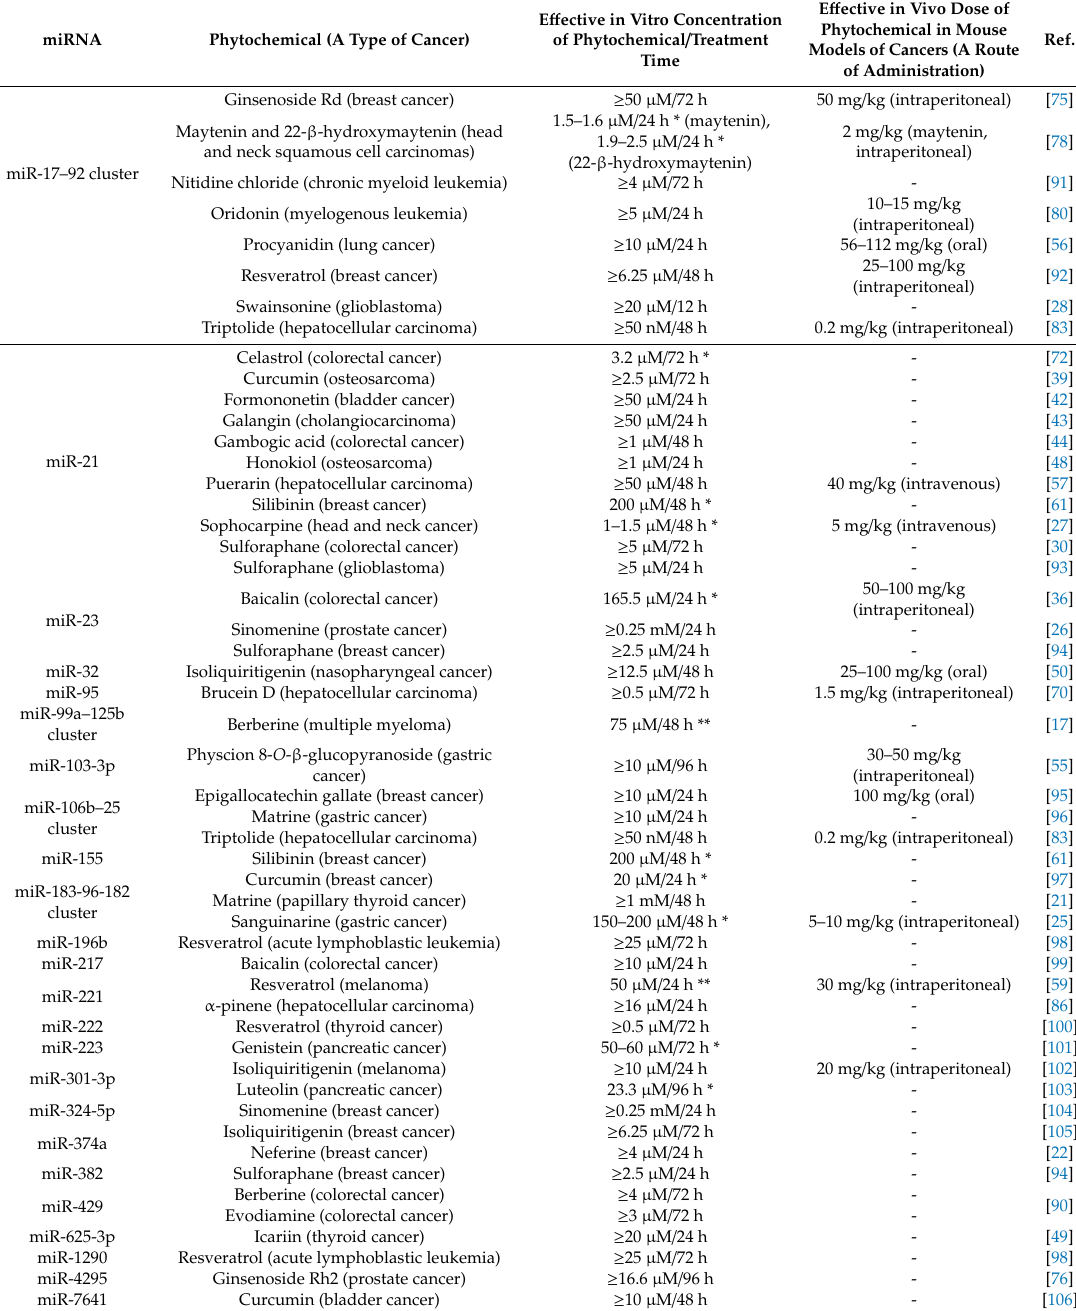
Table 3. Oncogenic miRNAs downregulated by phytochemicals in cancer. miRNA Phytochemical (A Type of Cancer)